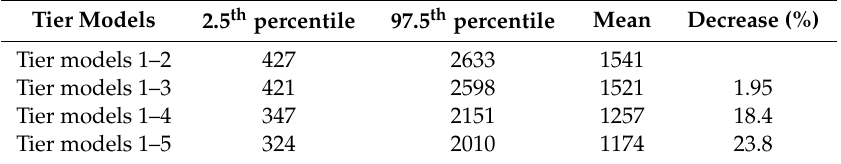
Table 5. Change in the annual mean estimates of mortality (predicted avoided mortalities) between the di ff erent exposure metrics and decrease between the estimated change in mortality predictions.